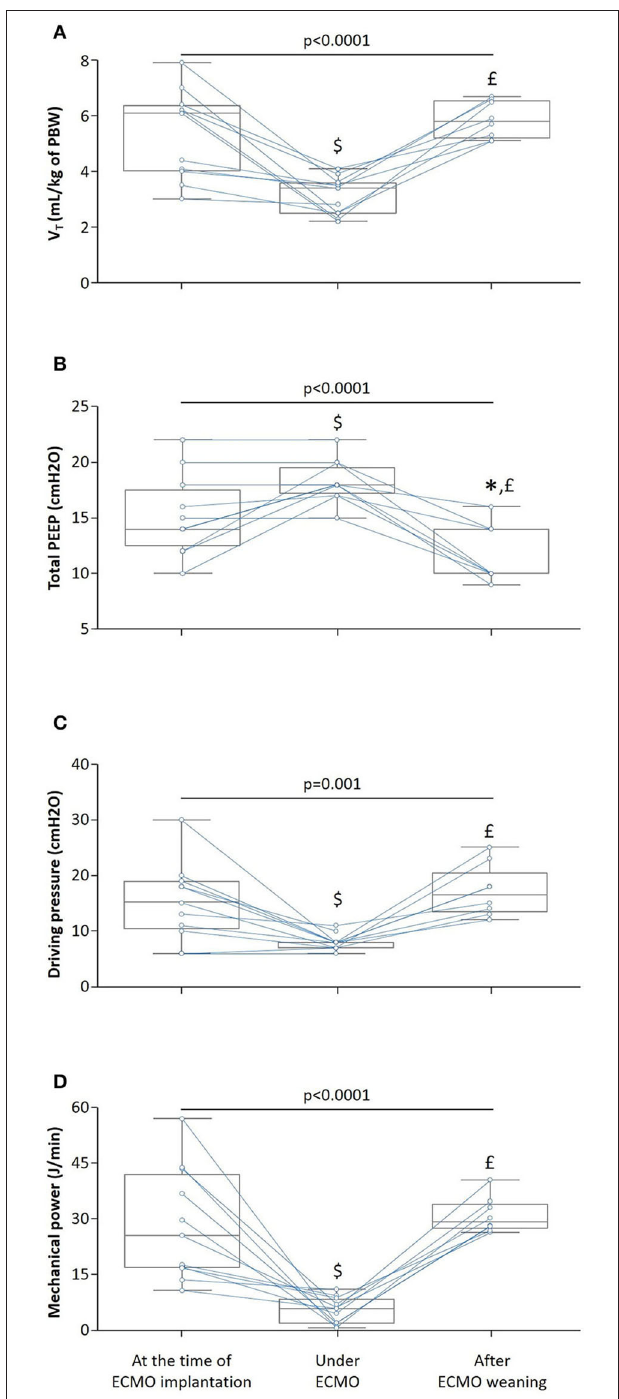
FIGURE 1 | Effects of venovenous extracorporeal membrane oxygenation (ECMO) on mechanical ventilation. The box show the 25th and 75th percentiles, the line in the box the median and the whiskers the minimum and maximum values. Blue lines indicate individual changes. n = 11, p -value for Friedman test, * p < 0.05 after ECMO weaning vs. at the time of ECMO implantation, $ p < 0.05 after ECMO weaning vs. under ECMO and $ p < 0.05 under ECMO vs. at the time of ECMO implantation. (A) Tidal volume (V T ). (B) Total positive end-expiratory pressure (PEEP). (C) Driving pressure. (D) Mechanical power. PBW, predicted body